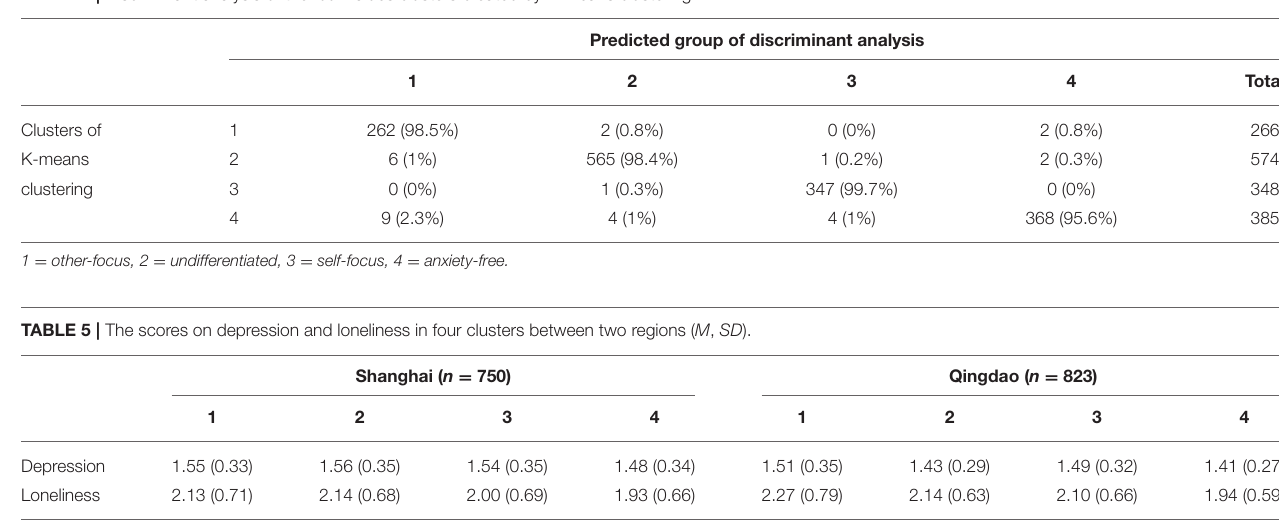
TABLE 4 | Discriminant analysis of the four values clusters created by K-means clustering.